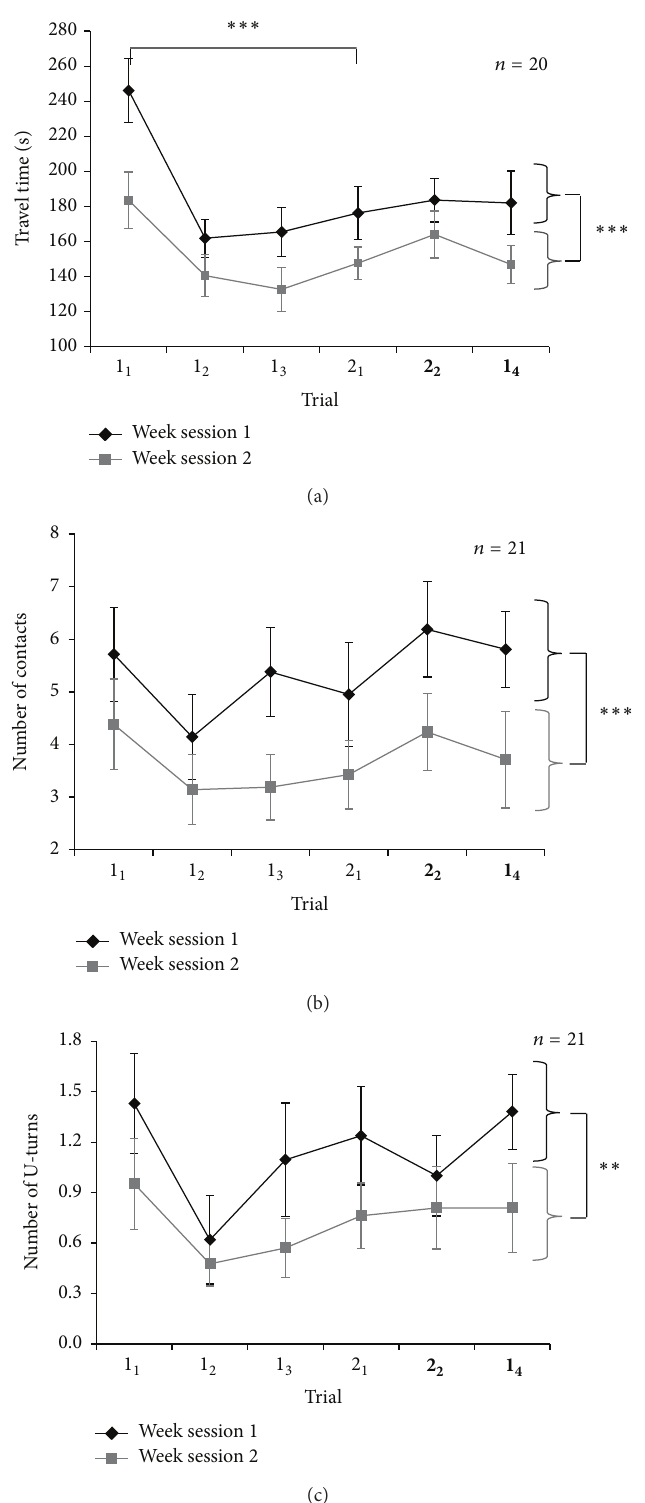
Figure 5: Navigation performance in the six experimental trials during the first and the second week sessions. Trials 1 1 , 1 2 , 1 3 , and 1 4 are conducted on the same path and trials 2 1 and 2 2 on another one. Cognitive load was added in trials 2 2 and 1 4 . Top panel (a): travel time in seconds (note that the 𝑌 -axis starts from 100s); middle panel (b): number of contacts with the walls; bottom panel (c): number of U-turns. Error bars represent standard errors of the means. Stars indicate significant differences with ∗∗ 𝑃 < 0.01 ; ∗∗∗ 𝑃 < 0.001